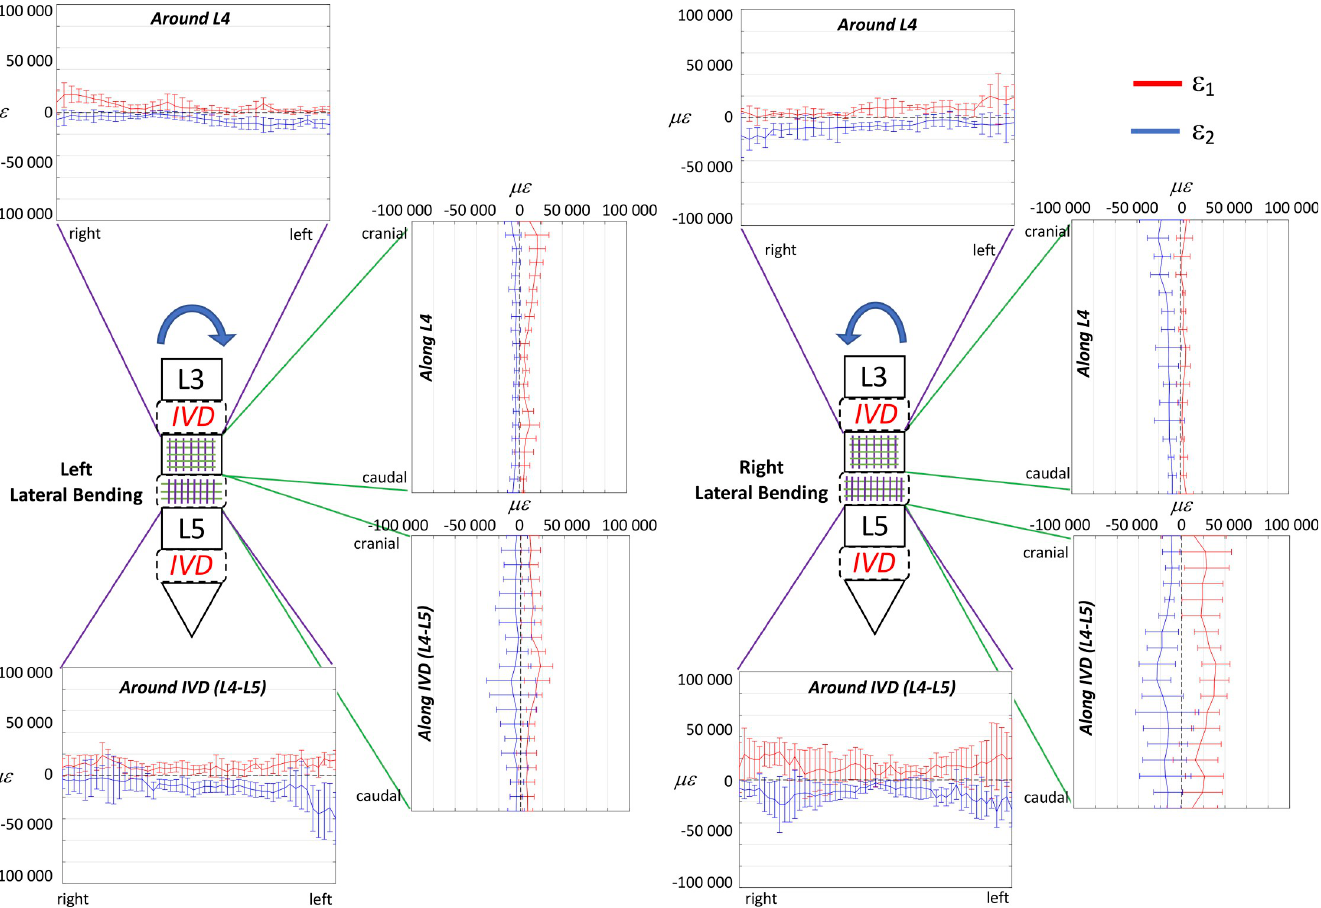
Fig 5. Lateral bending at the maximum loading (7.5 Nm): to describe the strain distribution of the ALL in the circumferential direction L, the median over cranio-caudal lines were computed in the sub-ROI in front of the L4 vertebra and in the sub-ROI in front of the L4-L5 IVD. Similarly, to describe the strain distribution of the ALL in the cranio-caudal direction, the median over circumferential lines were computed in the sub-ROI in front of the L4 vertebra and in the sub- ROI in front of the L4-L5 IVD. The plots show the distribution of eps 1 (red) and eps 2 (blue) circumferentially the L4 and the IVD (purple lines) and in the cranio- caudal direction of the L4 and the IVD (green lines). The median and standard deviation within the five specimens are reported.